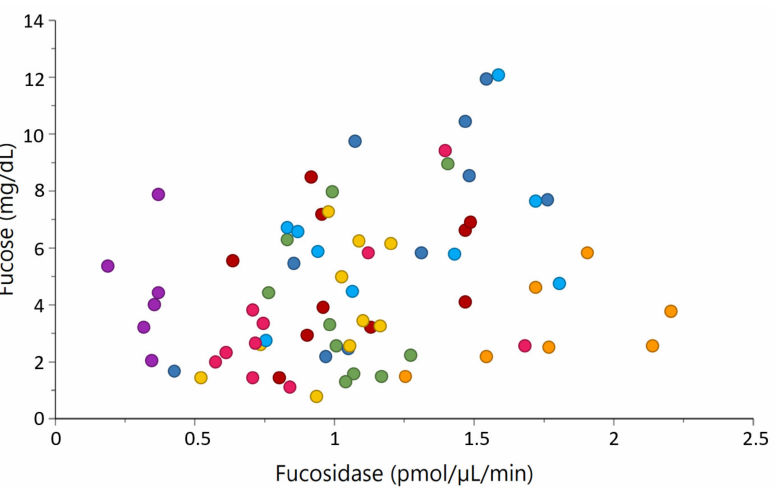
Figure 6. Relationship between the concentration of fucose and α -fucosidase activity (r = 0.37, p -value < 0.001). Each native breed is represented by a colour; Western Finncattle (WFC, pink), Norwegian Doela cattle (DOL, green), Eastern Finncattle (EFC, dark blue), Swedish Mountain cattle (SMC, purple), Icelandic cattle (IC, red), native Lithuania Black and White cattle (LT, yellow), Danish Red anno 1970 (RDM-70, light blue) and Norwegian Telemark cattle (TM,